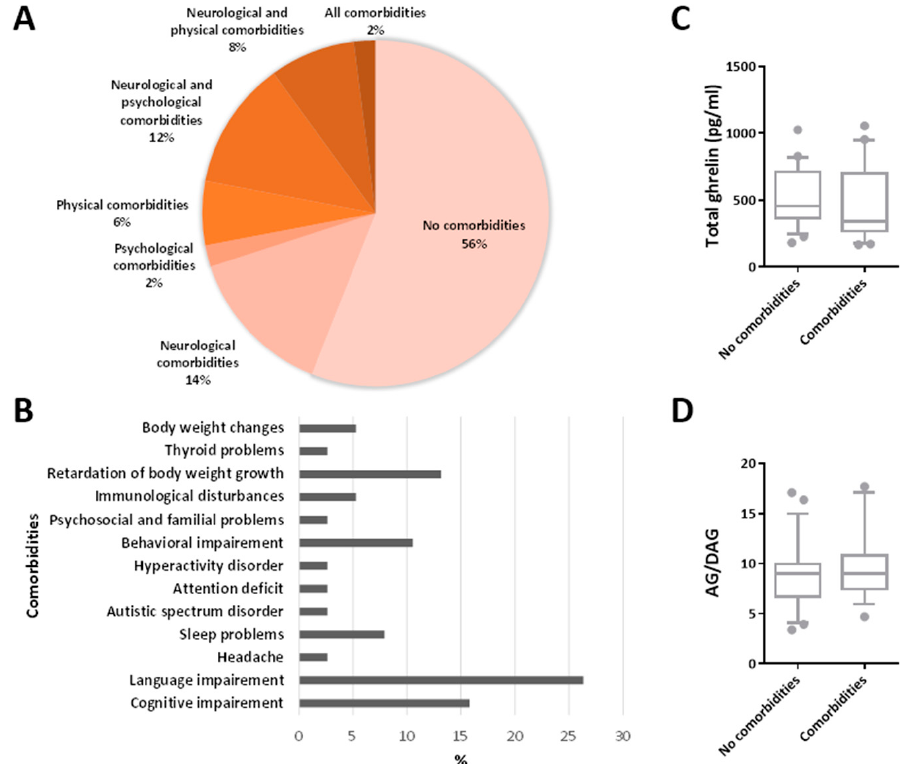
Figure 6. Total ghrelin and ghrelin (AG)-to-des-acyl ghrelin (DAG) ratio in plasma and comorbidities. In ( A ), the percentage of patients displaying comorbidities is reported. In ( B ), the prevalence of each type of comorbidity in the examined cohort of patients is represented in percentage. In comparison to children without comorbidities, the total ghrelin plasma levels and AG-to-DAG ratio were not significantly changed in children with newly diagnosed epilepsy, displaying comorbidities ( C , D ).